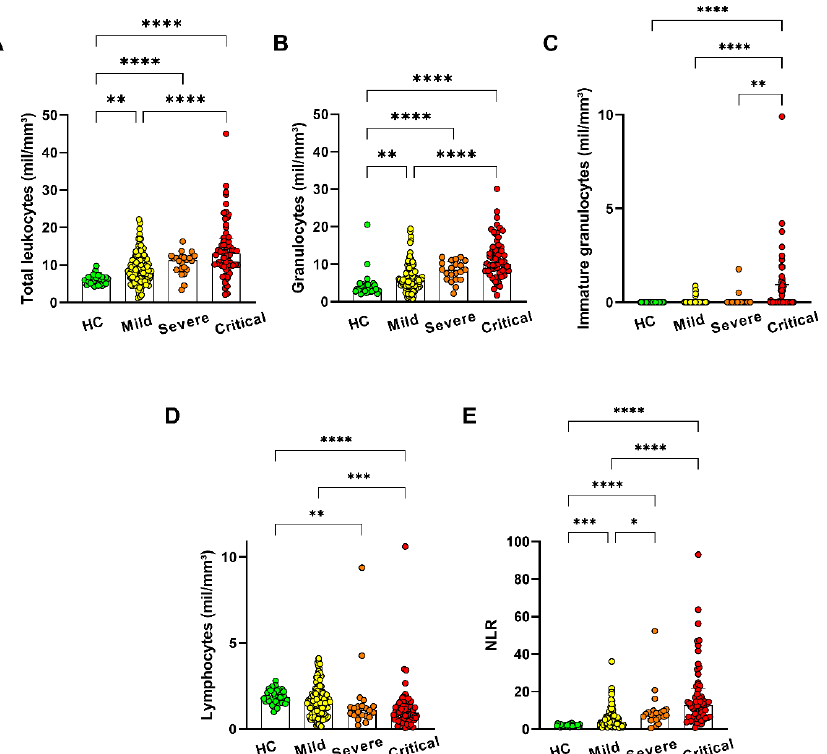
Figure 1. Blood neutrophilia with presence of immature neutrophils with COVID-19 infection severity. Blood count in ( A ) total leukocyte, ( B ) granulocytes, ( C ) immature granulocytes, ( D ) lymphocytes, and ( E ) the neutrophil/lymphocyte ratio (NLR) of patients with mild ( n = 110), severe ( n = 22), and critical ( n = 60) symptoms and healthy controls (HC n = 29). The bars represent the median and interquartile range. * p ≤ 0.05, ** p ≤ 0.01, *** p ≤ 0.001 and **** p ≤ 0.0001. The marker CD10 means mature neutrophils in the latest stage of differentiation, while CD33 represents immature neutrophils [18,19]. Despite no change in the percentage values, mildly infected individuals showed an elevated MFI expression of CD16+ in CD66+ (Figure S2). However, the expression of the marker CD10 in neutrophils CD66b+CD10+ decreased with the severity of the illness (Figure 2).